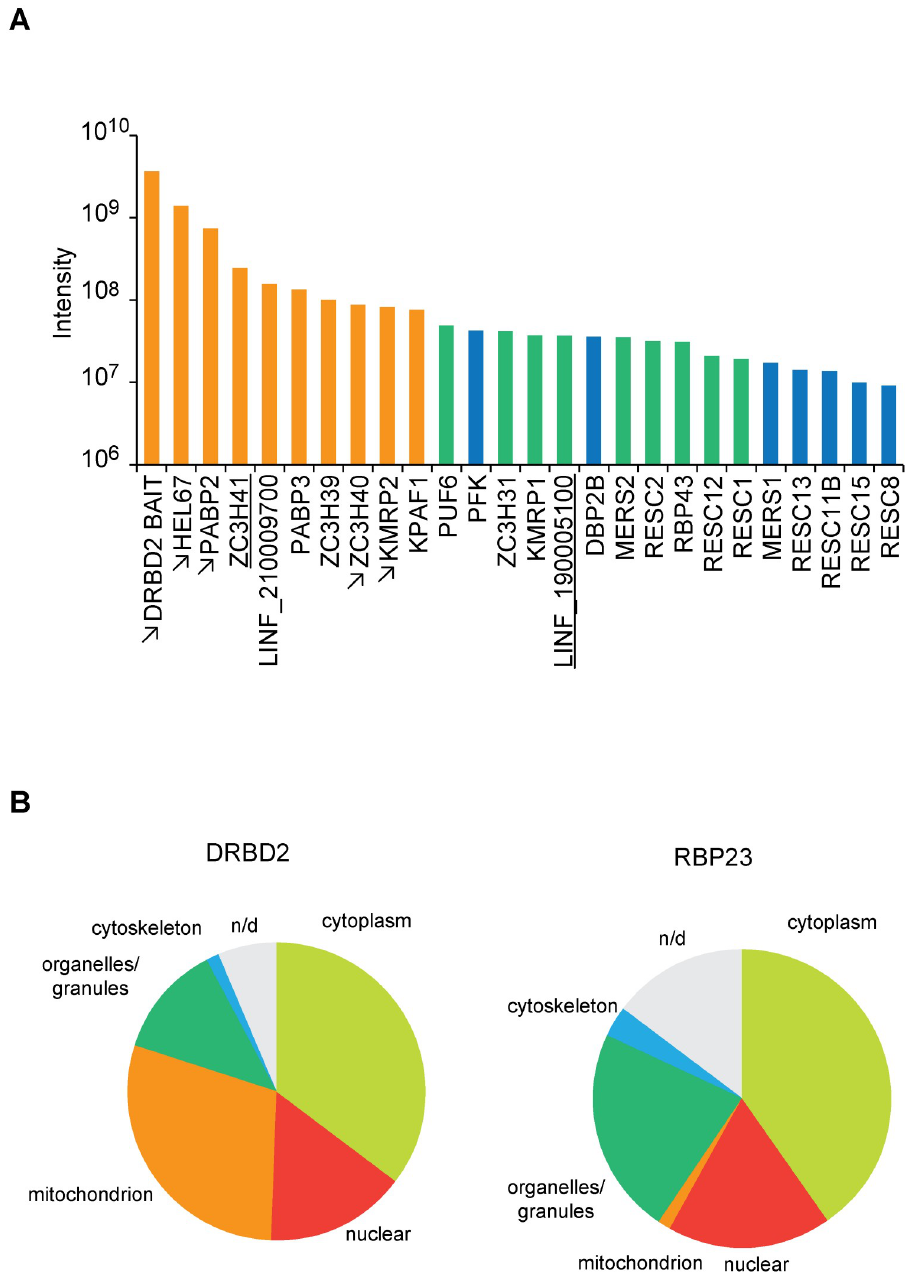
Fig 4. Top proteins co-purifying with HA-tagged DRBD2 and their subcellular compartmental localization compared to HA-tagged RBP23. ( A ) Bar chart with proteins co-precipitated with DRBD2 with the enrichment strength defined as ‘+++’ (orange), ‘++’ (green) and ‘+’ (blue), according to Table 2. Proteins co-purifying with both T. cruzi DRBD2 [45] and its L. infantum HA-tagged orthologue are indicated by arrows. Proteins in common with RBP23 are underlined. ( B ) Pie charts with subcellular localization of DRBD2 (left chart) or RBP23 (right chart) partners. This was defined based on cellular component classes: cytoskeleton; cytoplasm; mitochondrion; nuclear; organelles/granules (except mitochondria); n/d or not defined. For uncharacterized proteins, their localization was defined based on their respective orthologues from T . brucei and according to TrypTag.org.